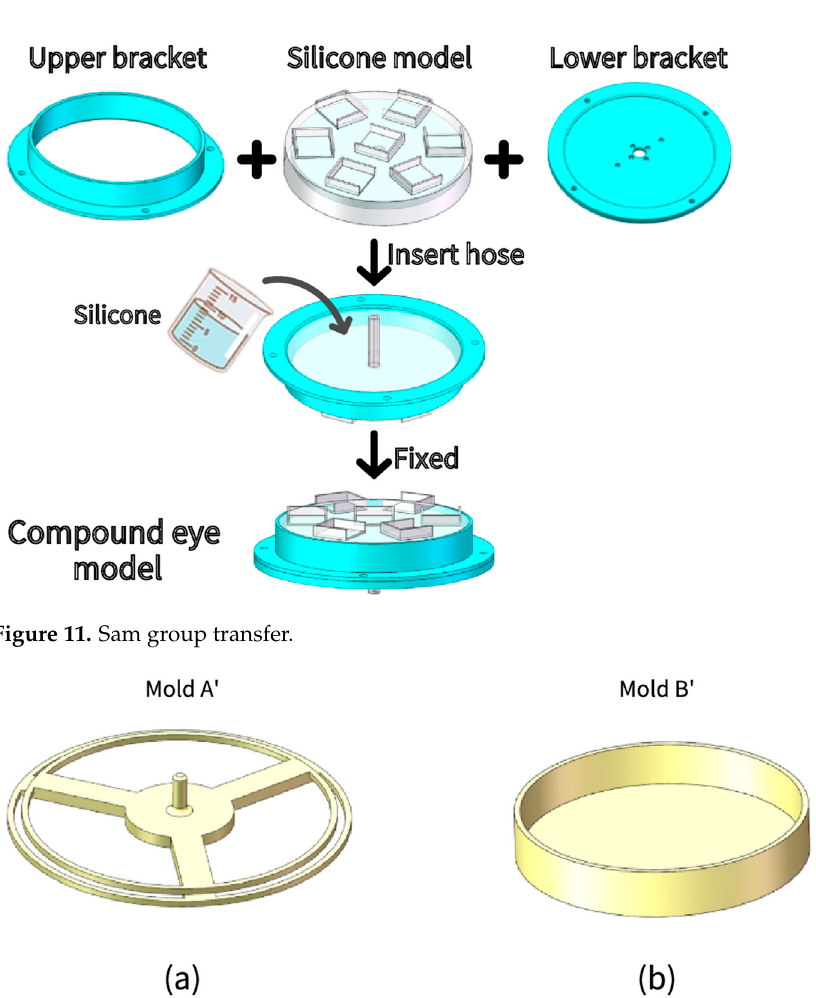
Figure 12. Double-layer structure design and manufacturing of the mold and CTPM manufacture mold. ( a ) Design mold for double-layer structure; ( b ) Mold for CTPM